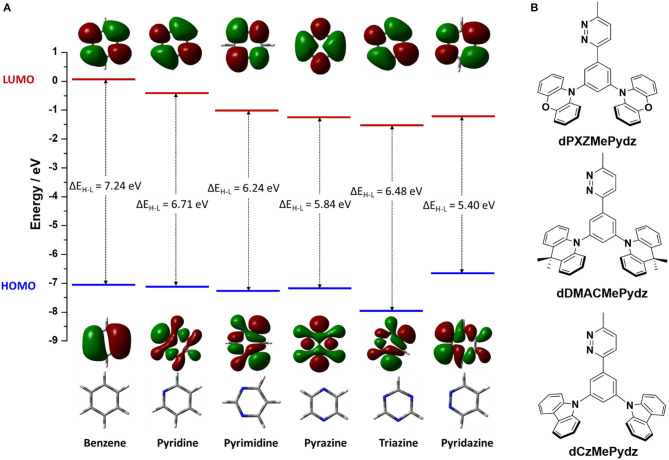
(A) Structure of benzene and other azines, together with their corresponding HOMO and LUMO electron density distributions (isovalue = 0.02) and energy levels, calculated at PBE0/6-31G(d,p) level in vacuum. (B) Chemical structures of compounds with pyridazine acceptor.